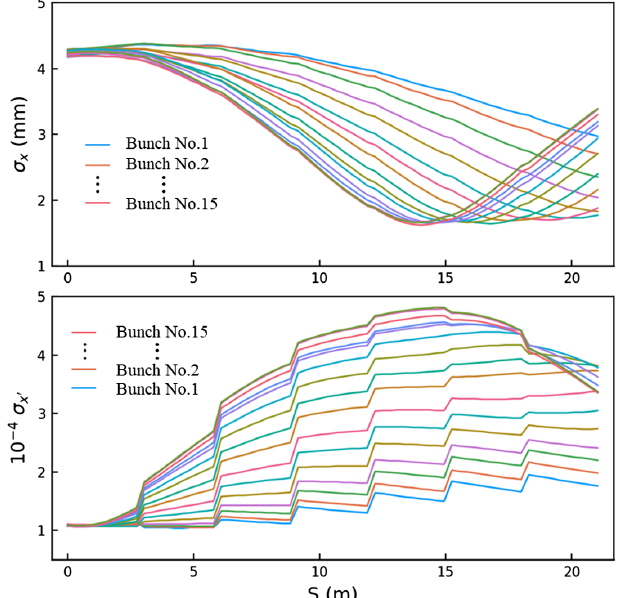
15 electron bunches along the CS of the yellow ring (the leaps on the momentum spread are due to the solenoid field).